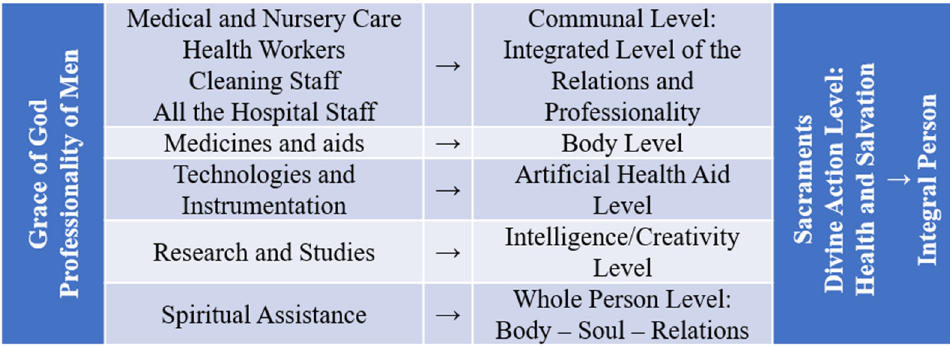
Figure 3. Integral care.